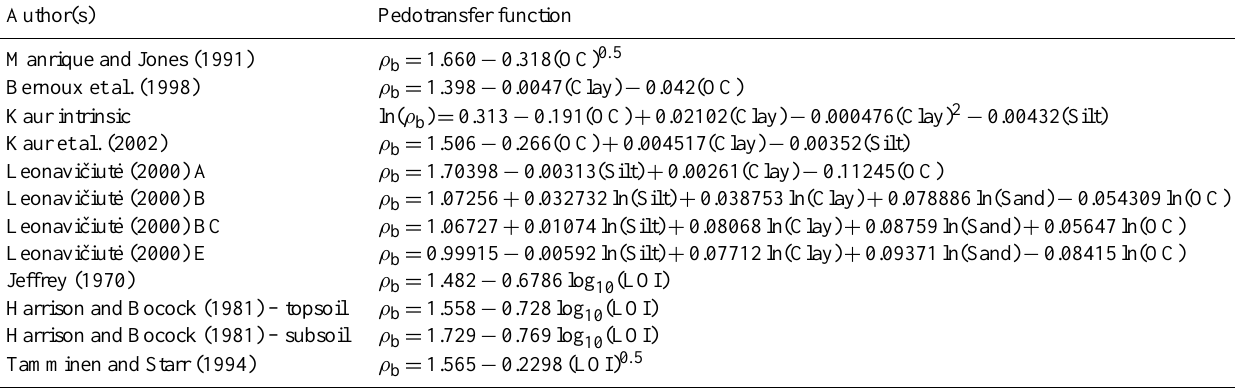
Table 2. Published pedotransfer functions with corresponding authors used in this study. OC is organic carbon. ρ b is bulk density in gcm − 3 .